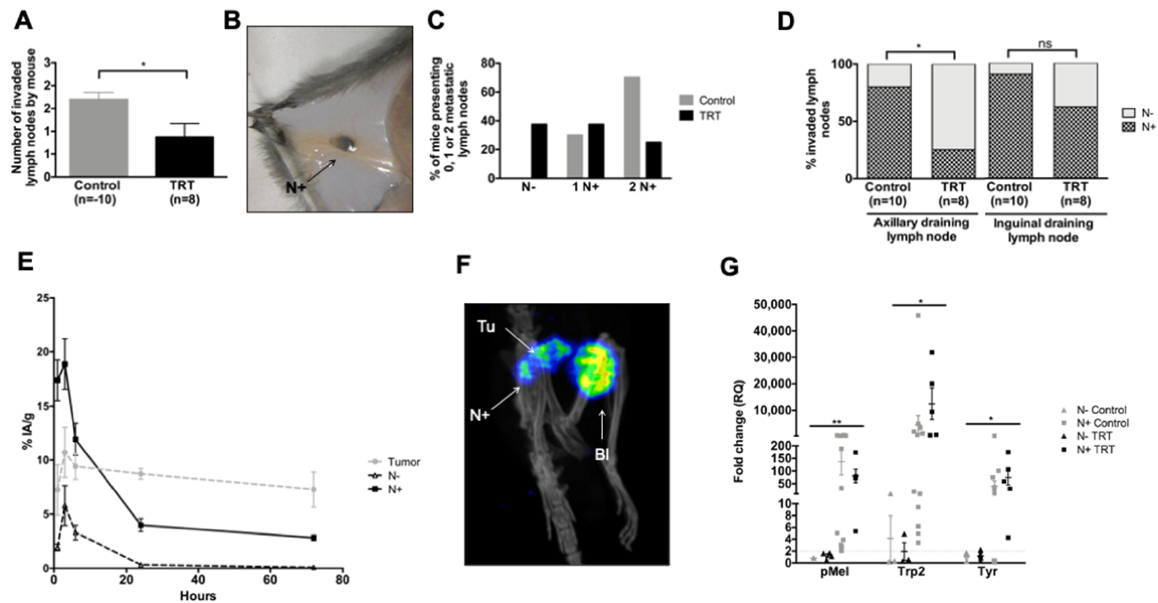
Figure 4. [ 131 I]ICF01012 decreases lymph-node dissemination. Results are presented as mean +/ − SD (A,E) and as median, 1st quartile, and 3rd quartile ( G ). ( A–E ) The numbering and topographic location of metastatic LNs (N+) were determined for each mouse 10 days after treatment (10 control, 8 TRT): number of N+ per mouse ( A ), typical N+ ( B ), proportion of mice presenting 0 (N − ), 1, or 2 N+ ( C ) , repartition of invaded LNs ( D ). The radioactivity present in (T) tumors and (N+) ( E ) was determined during biodistribution studies on three mice per timepoint (1, 3, 6, 24, and 72 hours after injection): 24 LNs were macroscopically metastatic (N+) and 32 were non-metastatic (N − ). ( F ) Visualization of an N+ by SPECT-CT imaging (T: tumor, N: lymph node, Bl: bladder). ( G ) . Trp2, pMel, and Tyr gene expression in axillary and inguinal draining LNs was measured by RT-qPCR in 18 N+ (control group: n = 13 and TRT group: n = 5) and 7 N − (control group: n = 3 and TRT group: n = 4). LNs were considered to be metastatic when they showed a ≥ 2-fold change for at least two genes. (* p < 0.05 , ** p < 0.01).